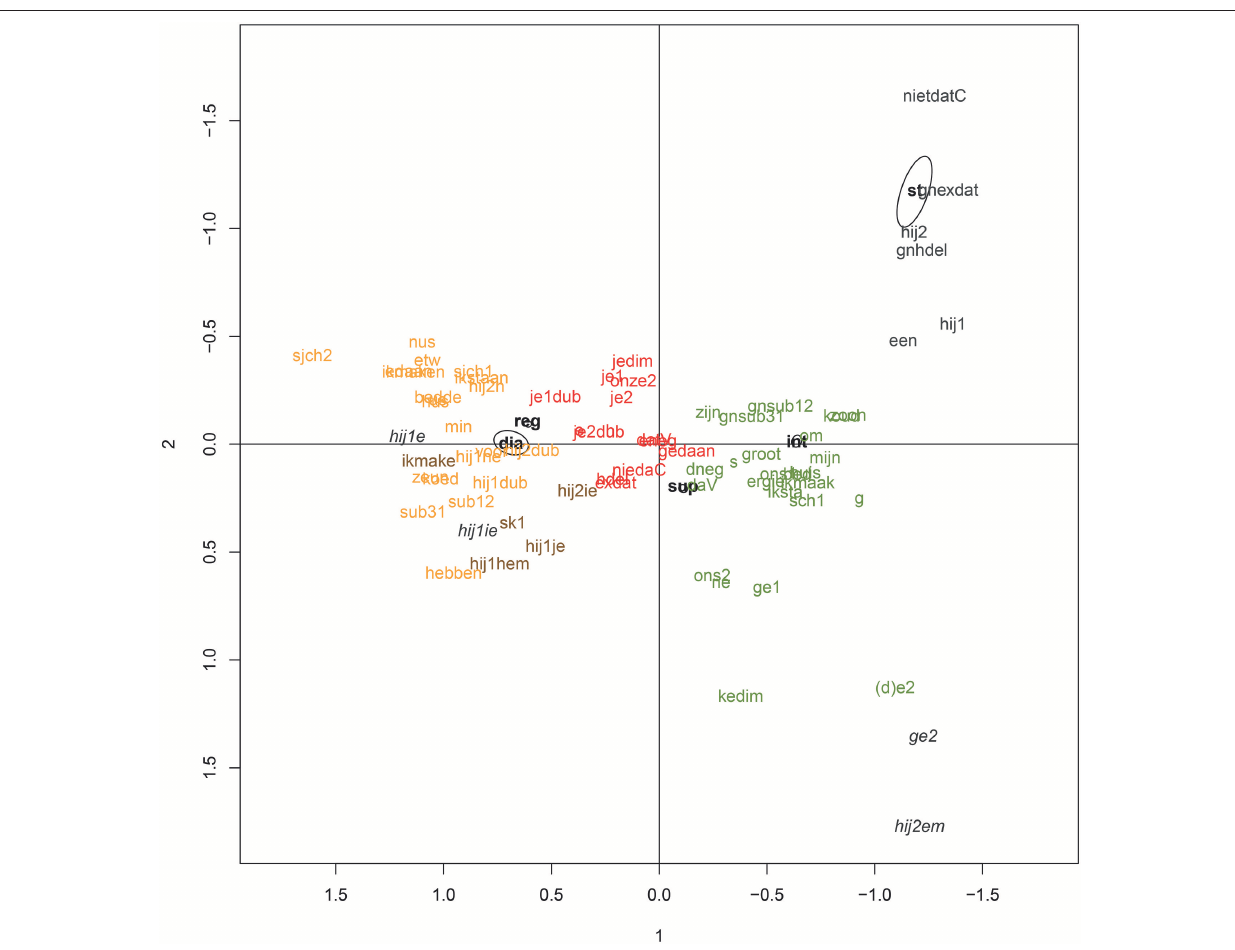
know... who... who... yes... kind of... yes come from